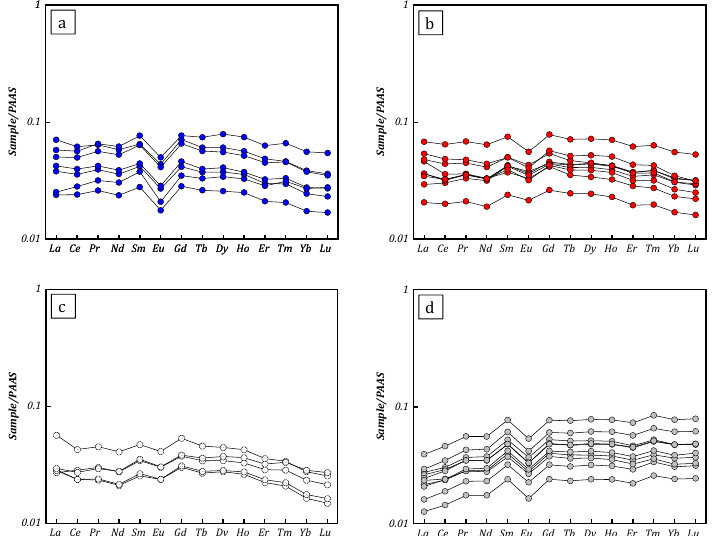
Figure 6. PAAS-normalized REEs partition patterns of different types of the examined D1 ( a ), D2 ( b ), D3 ( c ), and SD ( d ) dolomites in the Xixiangchi Formation. Note the REE compositions of some of D1, D2, and SD samples have been previously reported by Liang et al. [45]. See Tables S2 and S3 for details.